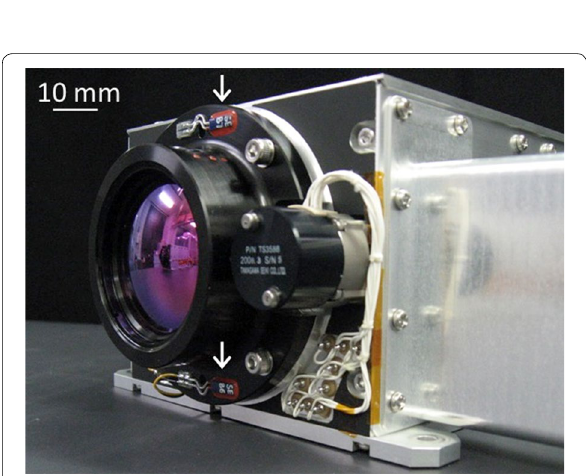
Fig. 8 Photograph of the Ge lens mounted to the LIR aperture. White arrows indicate positions of the thermal sensors put on the lens